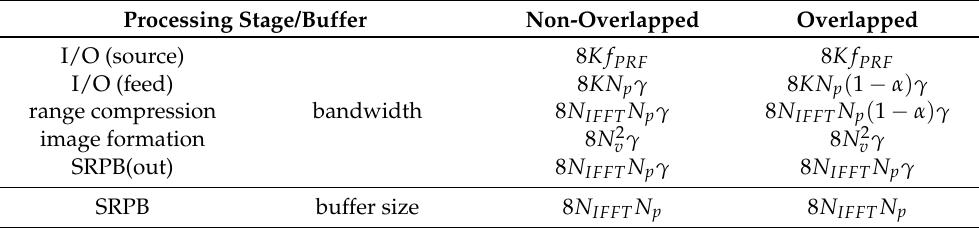
Table 4. Bandwidth and buffer sizes in the BP-VISAR architectures with full-aperture